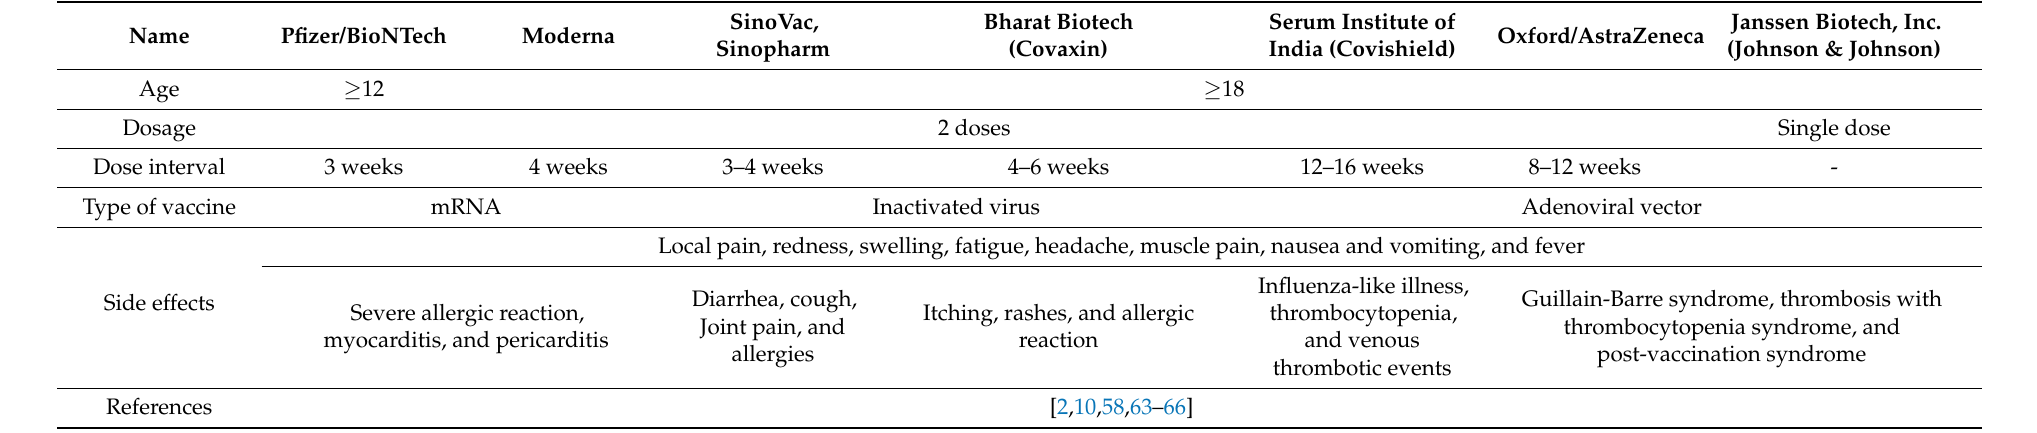
Table 3. COVID-19 vaccines authorized for emergency use during pregnancy and the reported side